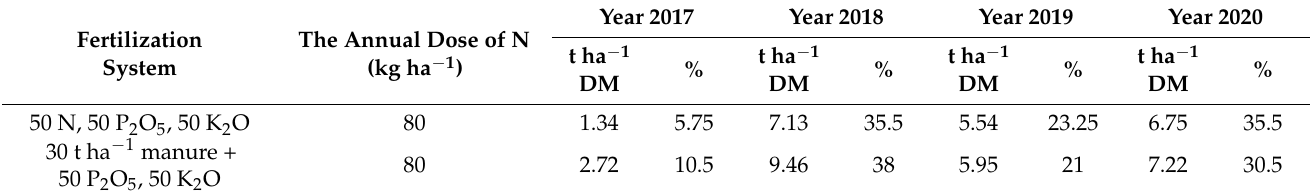
Table 4. The dynamics per year of the production of the temporary grassland from Horezu–V â lcea